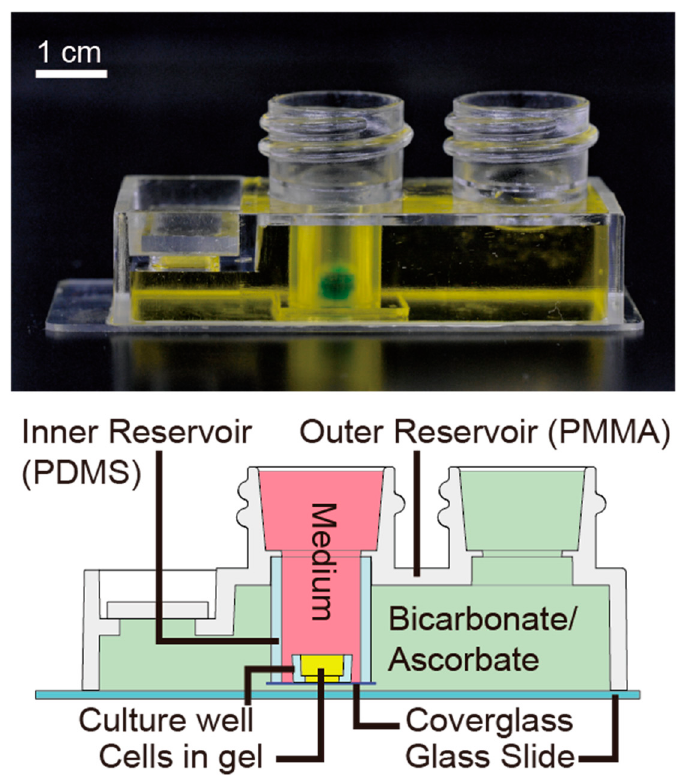
Figure 1. Portable device for the development or vascular networks under controlled oxygen and carbon dioxide concentrations. The device consists of two reservoirs: the inner reservoir where cells are cultured inside a fibrin-collagen hydrogel at the bottom, and the outer reservoir made of polymethylmethacrylate (PMMA) for the bicarbonate buffer/ascorbate solution. These reservoirs are divided by a tubular wall made of poly(dimethylsiloxane) (PDMS), where gas (O 2 and CO 2 ) and moisture exchange occurs.